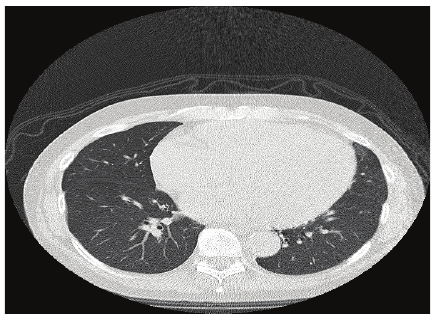
Figure 3: CT scan showing complete remission.